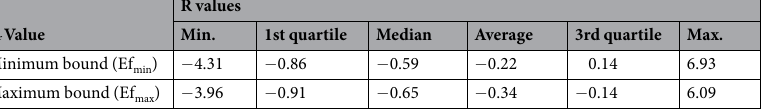
Table 1. Distribution of the relative differences in GHG intensity between bioenergy and fossil-based equivalents ( R ), calculated with the lower and upper bounds for the emissions of fossil chains (Ef min and Ef max ).